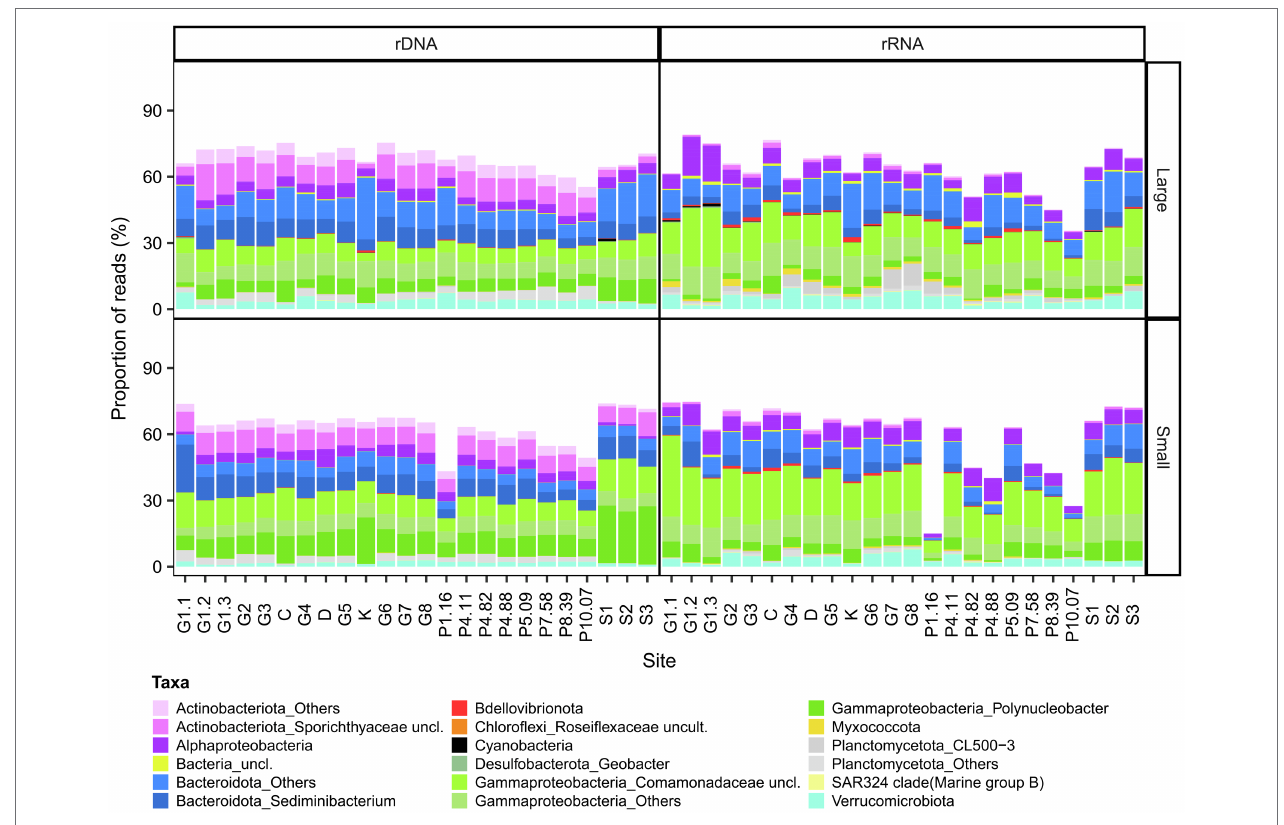
FIGURE 4 | Bacterial composition of the core microbiome in GWR and associated waters. The values are % reads for 16S rDNA or rRNA in the large (top) and small (bottom)